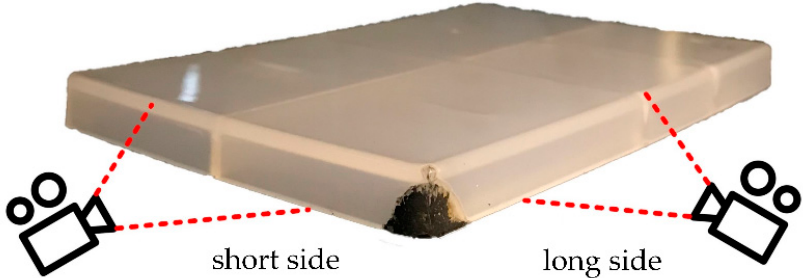
Figure 2. One of molded parts.